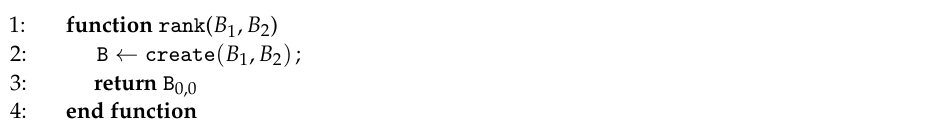
Algorithm 7 computes the number of full key candidates in [ B 1 , B 2 ) .